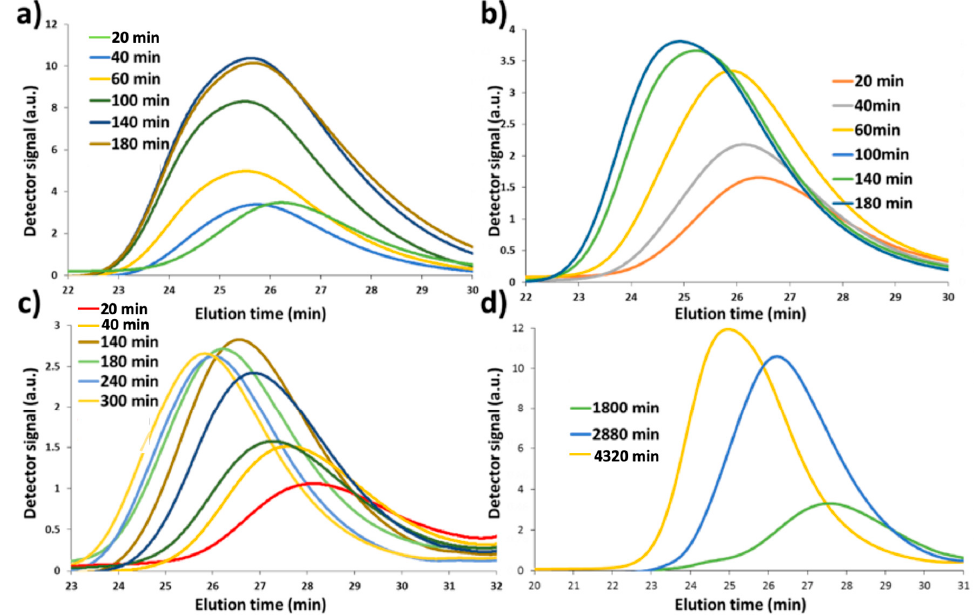
Figure 6. GPC traces of DBI-S copolymerizations (f DBI,0 = 0.50 in all cases) done at ( a ) 110 °C, ( b ) 100 °C, ( c ) 80 °C and ( d ) 70